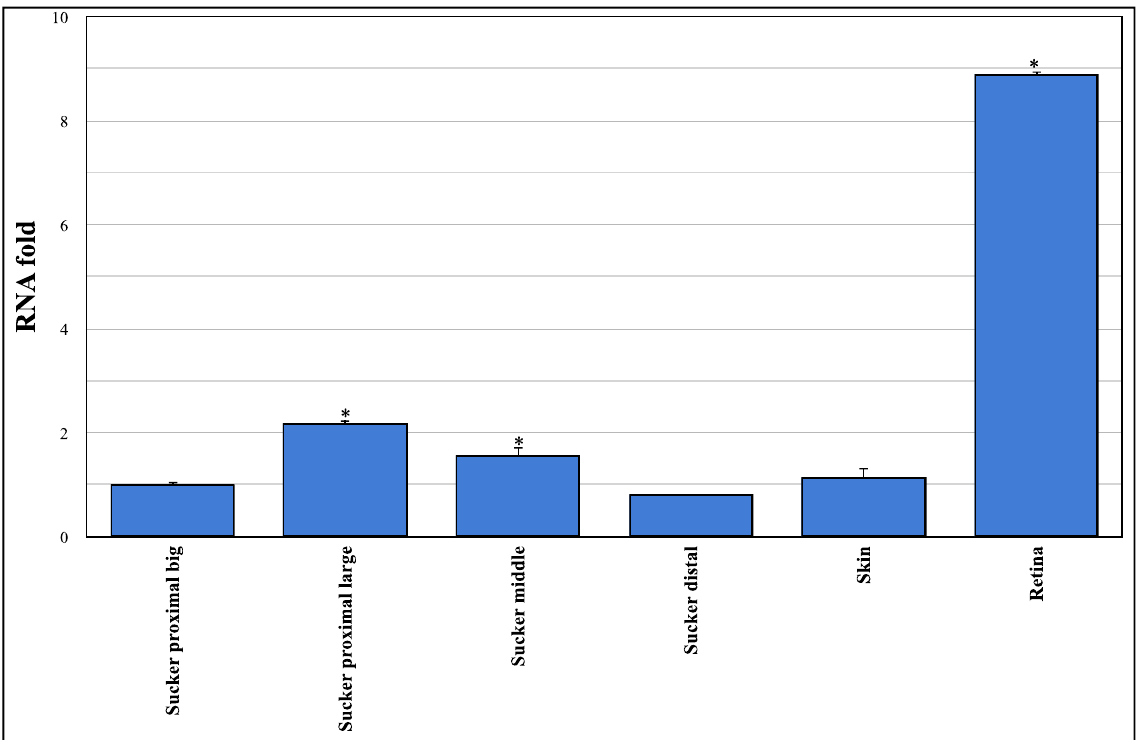
Figure 2. Gene expression analysis for mRNA of Rhodopsin kinase receptor gene (Ov-GRK1) of different tissues. Relative mRNA expression levels were measured using real-time analysis and calculated by the 2 (−ΔΔC(T)) method. Each sample ( n = 3) was tested and run in duplicate. The heart tissue was used as a negative control. The ubiquitin gene was amplified as an internal control. No-template controls were included. Relative mRNA fold change in gene expression was compared to the proximal big sucker (set y = 1). * asterisk indicates that the difference vs. sucker proximal big is statistically significant (Wilcoxon-test, p < 0.05). The Kruskal–Wallis test showed that there was a statistically significance between groups ( p < 0.05). Error bars represent the SEM.